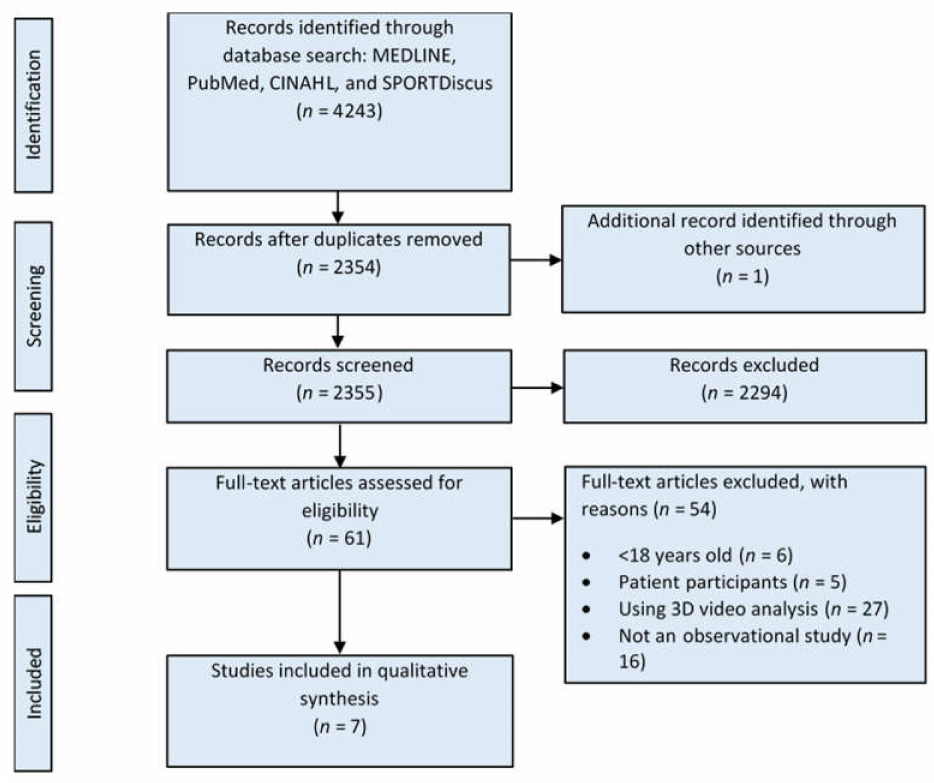
Figure 1. A flow diagram depicting the search process used in this